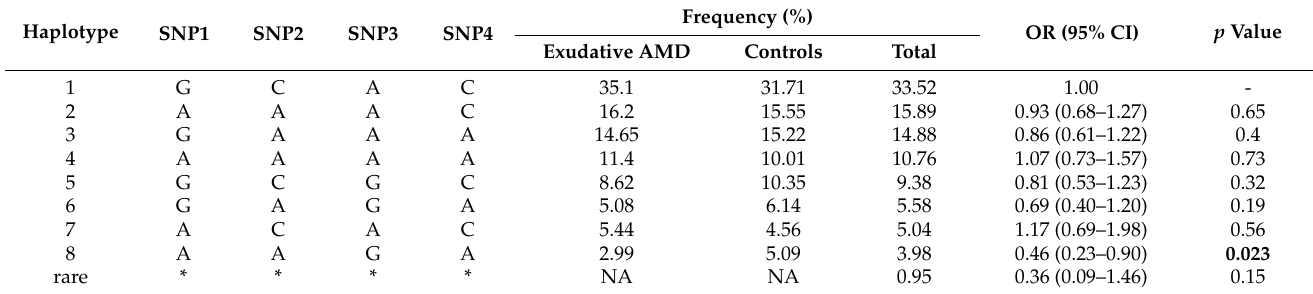
Table 6. Associations between VEGFA haplotypes and risk of exudative